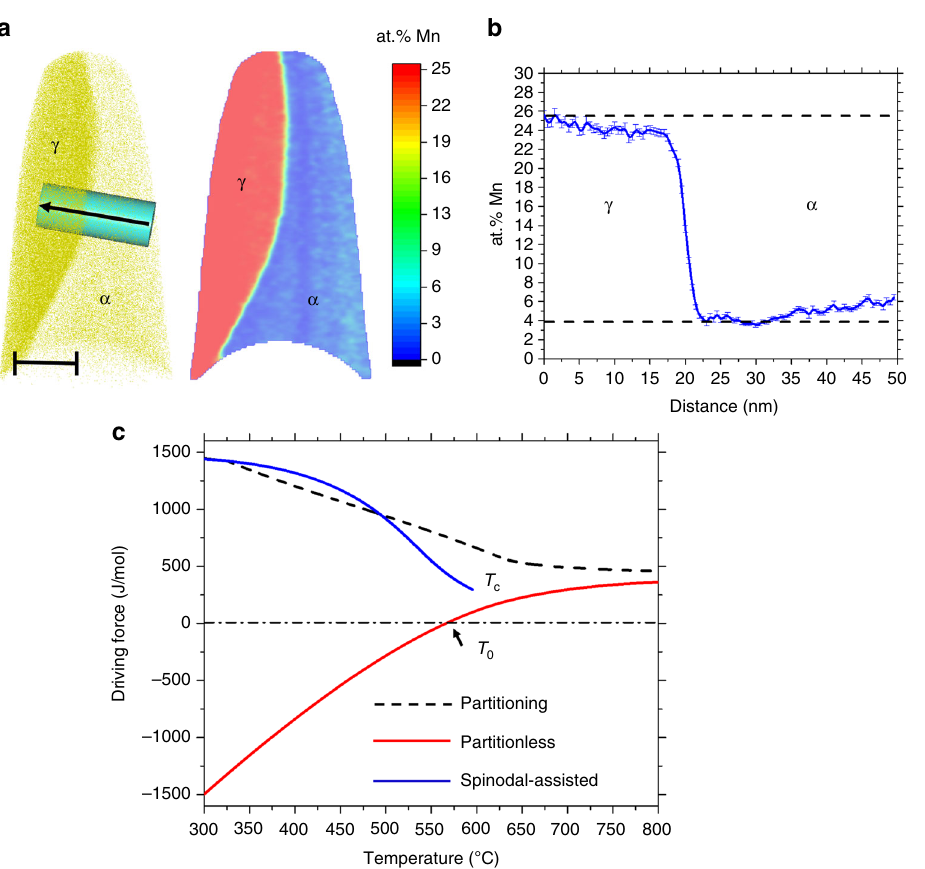
Fig. 8 APT results after 2 months of annealing at 450 °C. a APT reconstruction and a 2D compositional map showing an austenite grain in stage of growth. b 1D compositional pro fi le along the cylinder showed in a . c Different driving forces for austenite formation from an Fe-9 at.% Mn BCC matrix. The partitioning driving force is the difference in free energy between the Fe-9 at.% Mn BCC matrix and the free energy of the equilibrium point of the mixture of ferrite and austenite. The partitionless driving force is the difference in the free energy between an Fe-9 at.% Mn BCC phase and the austenite phase with the same composition. The spinodal-assisted driving force is the difference in free energy between the Mn-rich BCC phase and the austenite phase with the same composition. T c is the critical temperature of the miscibility gap. T 0 is the temperature at which the free energy of the Fe-9 at.%Mn BCC phase is equal to the free energy of the austenite phase with the same composition. T c is the critical temperature of the miscibility gap and the end of the spinodal-assisted curve. α represents the BCC-ferrite phase and γ represents the FCC-austenite